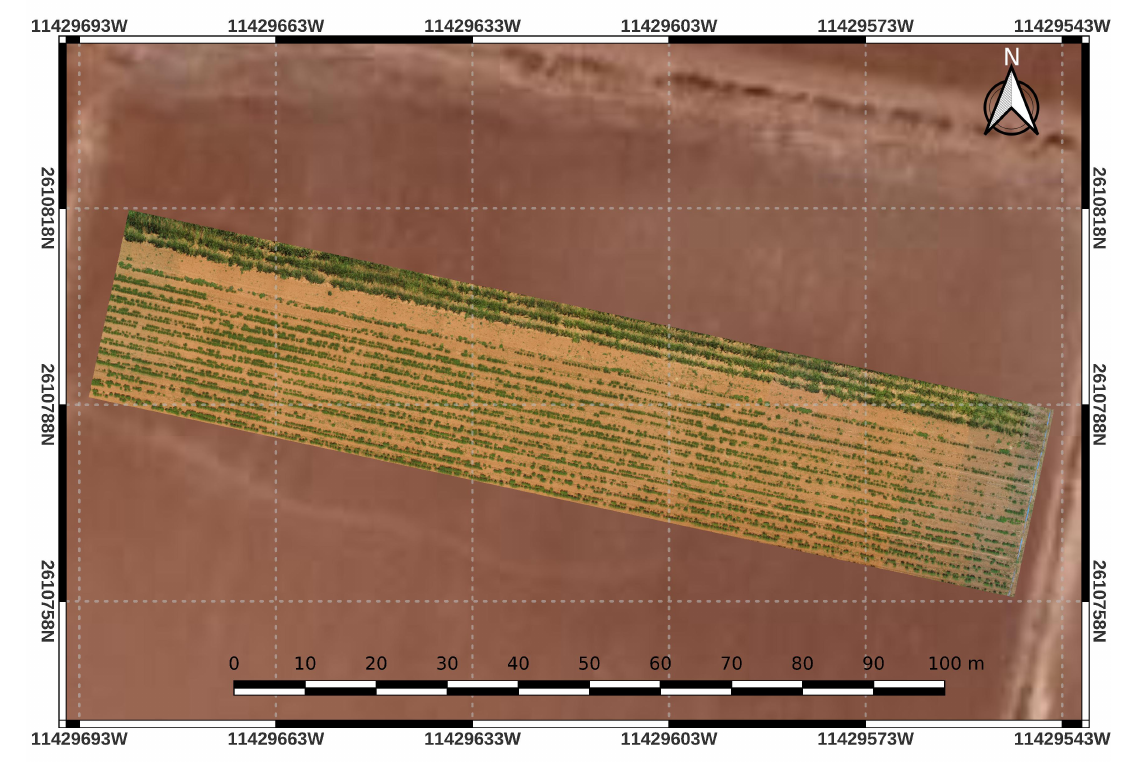
Figure 1. Study Area. RGB orthomosaic of the C. Annuum crop’s portion under study.